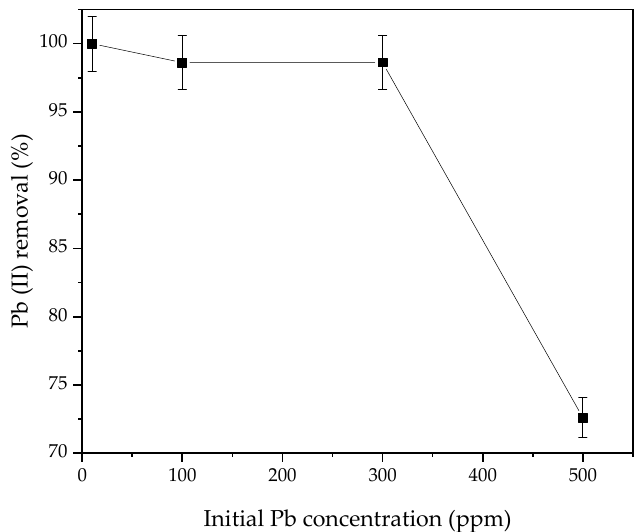
Figure 8. Effect of initial Pb(II) concentration on the adsorption on the 0.3NH 2 /DMS ‐ 1 material. Conditions: 20 mL of 100 ppm of Pb(II) ions solution, 0.10 g of adsorbent; contact time 60 min, temperature solution 30 °C; solution pH 5